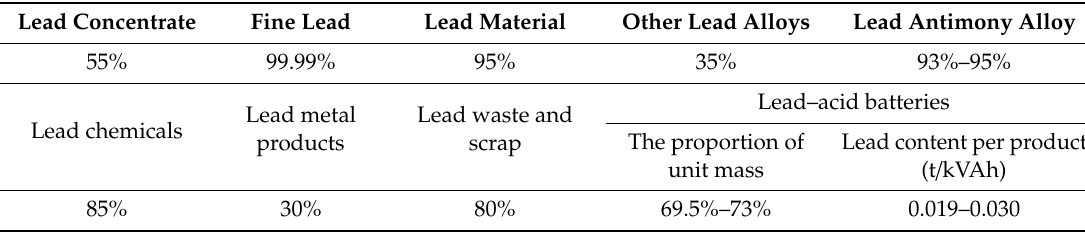
Table 2. Lead content in major leaded